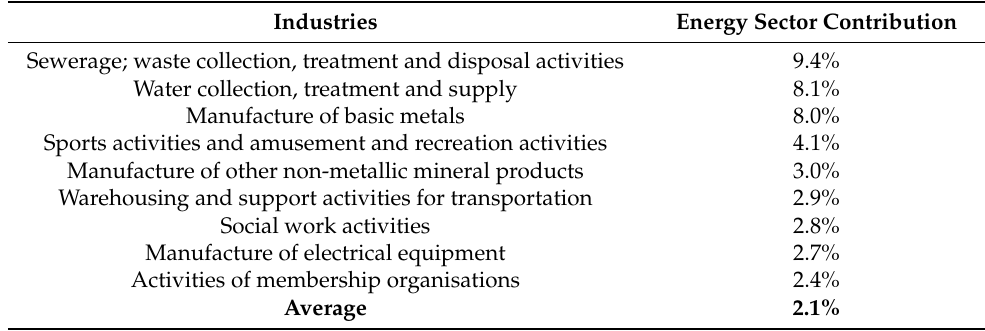
Table 2. The contribution of the Energy sector to the price formation of the other